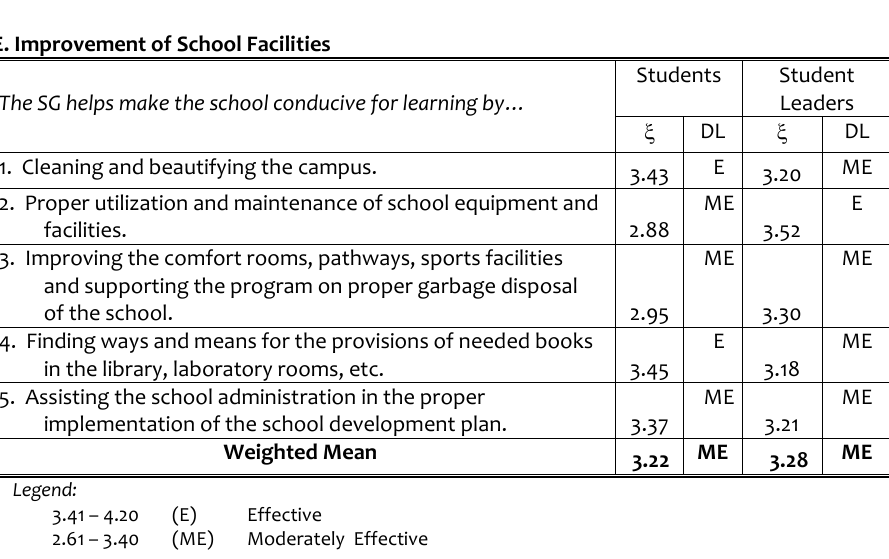
Table 2.e presents the level of effectiveness of performance of the Student Government of North Luzon Philippines State College as perceived by the respondents along improvement of school